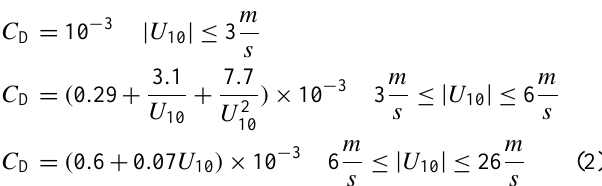
Figure 1. Geography of the southern Adriatic and northern Io- nian seas. The black squares show the areas used to estimate the time series in Fig. 2. The grey contours indicate the isobaths be- tween 200 and 1200m with the 200m line space. Colours show the mean altimetry pattern in the period October 1992–December 2013; altimetry grid points located within 50km from the coast have been deleted. The Adriatic square includes 81 altimetry measure- ment points; the Ionian square includes 232 altimetry measurement